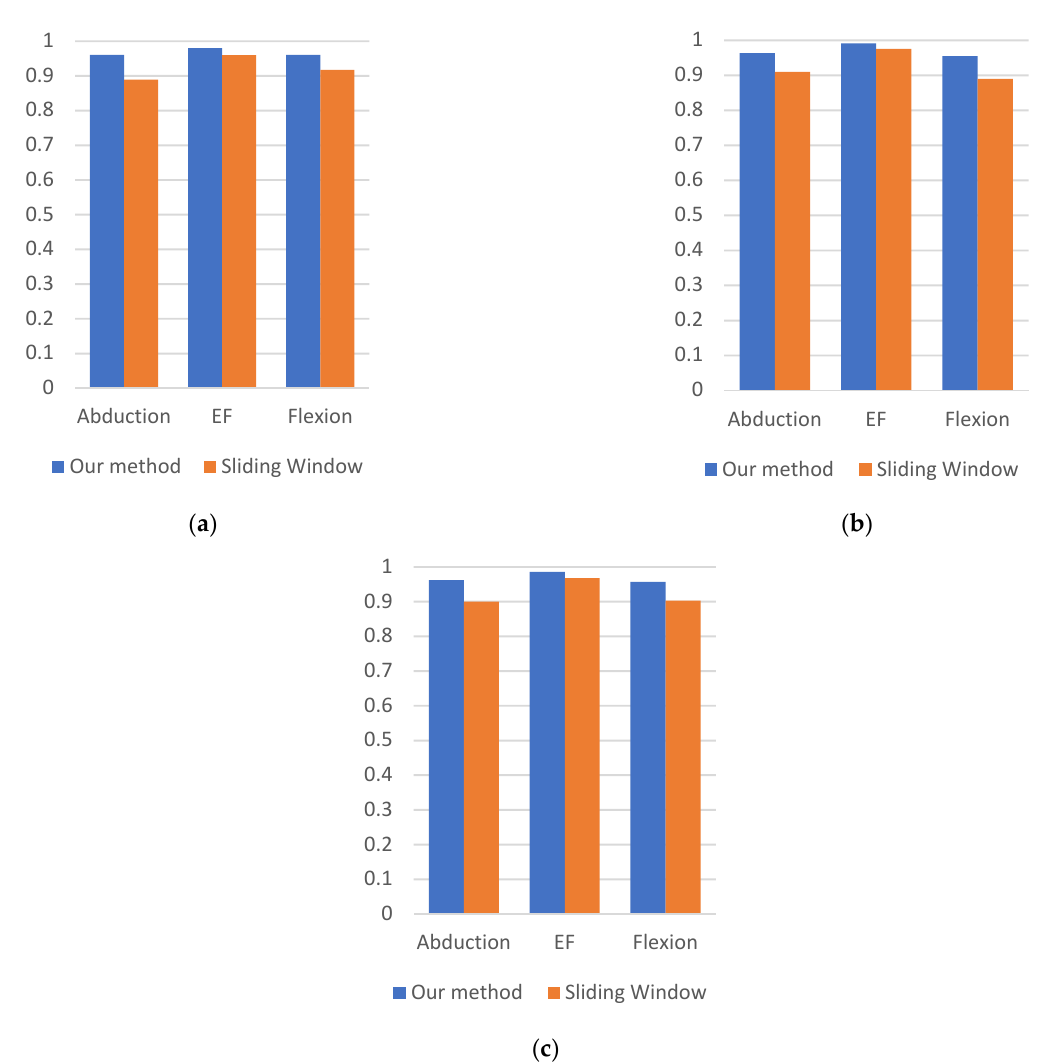
Figure 8. Performance comparison of each activity using: ( a ) Recall; ( b ) Precision; ( c ) F-measure.